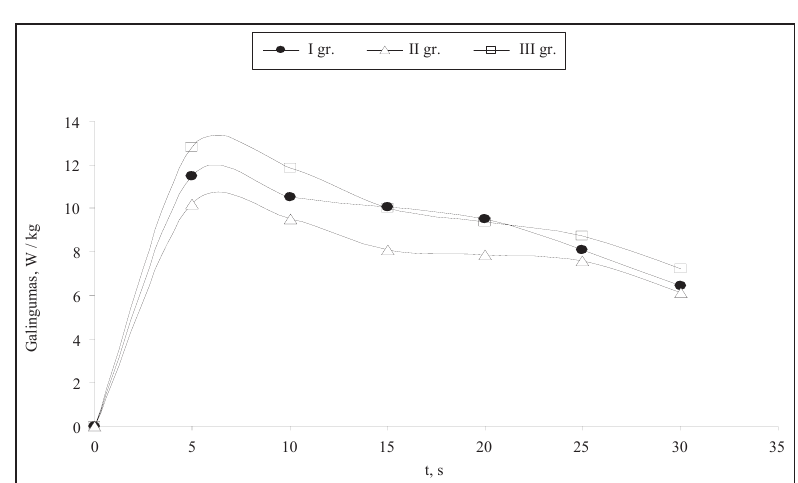
dikli ų vidurkio sklaida. Sklaidos plotas č ia sudar ė 4,54 W / kg, o mažiausias rodiklis nuo didžiausio skyr ė si daugiau kaip du kartus. I grup ė s žaid ė j ų ŠSD reakcija į 30 s didžiau- sio intensyvumo fizin į kr ū v į siek ė vidutiniškai 169,77 tv. / min. II ir III grup ė s ŠSD rodikli ų vidurkiai staistiškai nesiskyr ė (p > 0,05). At- sigavimo metu, po 1, 2 ir 3 minu č i ų , ŠSD tarp grupi ų vidurki ų statistiškai nesiskyr ė . Ta č iau labiausiai per pirm ą poilsio minut ę suret ė jo jaun ų j ų krepšininki ų ŠSD. Jis vidutiniškai su- ret ė jo 30,84 tv. / min, kai tuo tarpu klubo krep- šininki ų ŠSD suret ė jo 26,5 tv. / min (skirtumas tarp ši ų grupi ų statistiškai nepatikimas). Per antr ą poilsio minut ę jaun ų j ų krepšininki ų ŠSD vidutiniškai suret ė jo dar 23,16 tv. / min, per tre č i ą ⎯ dar 9,46 tv. / min. Kit ų grupi ų ŠSD kaitos tendencijos buvo panašios ir statistiškai patikimo skirtumo tarp j ų nebuvo. Taip pat ma- tyti, kad atsigavimo metu maž ė jant vis ų trij ų grupi ų vidutiniams ŠSD rodikliams j ų vidurki ų sklaida did ė jo. Tai rodo, kad žaid ė jos atsigauna labai skirtingai.